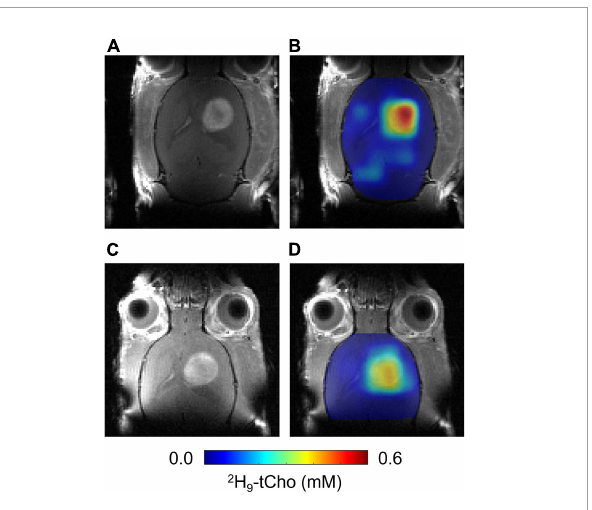
FIGURE4 In vivo DMI 24 h after infusion of 2 H 9 -Cho. (A,C) CE T1W MRI of same RG2-bearing rat acquired before 36 min infusion of 2 H 9 -Cho (A) and 24 h later (C) . (B,D) Interpolated color-coded maps of 2 H-tCho based on DMI data acquired during (B) , and 24 h after